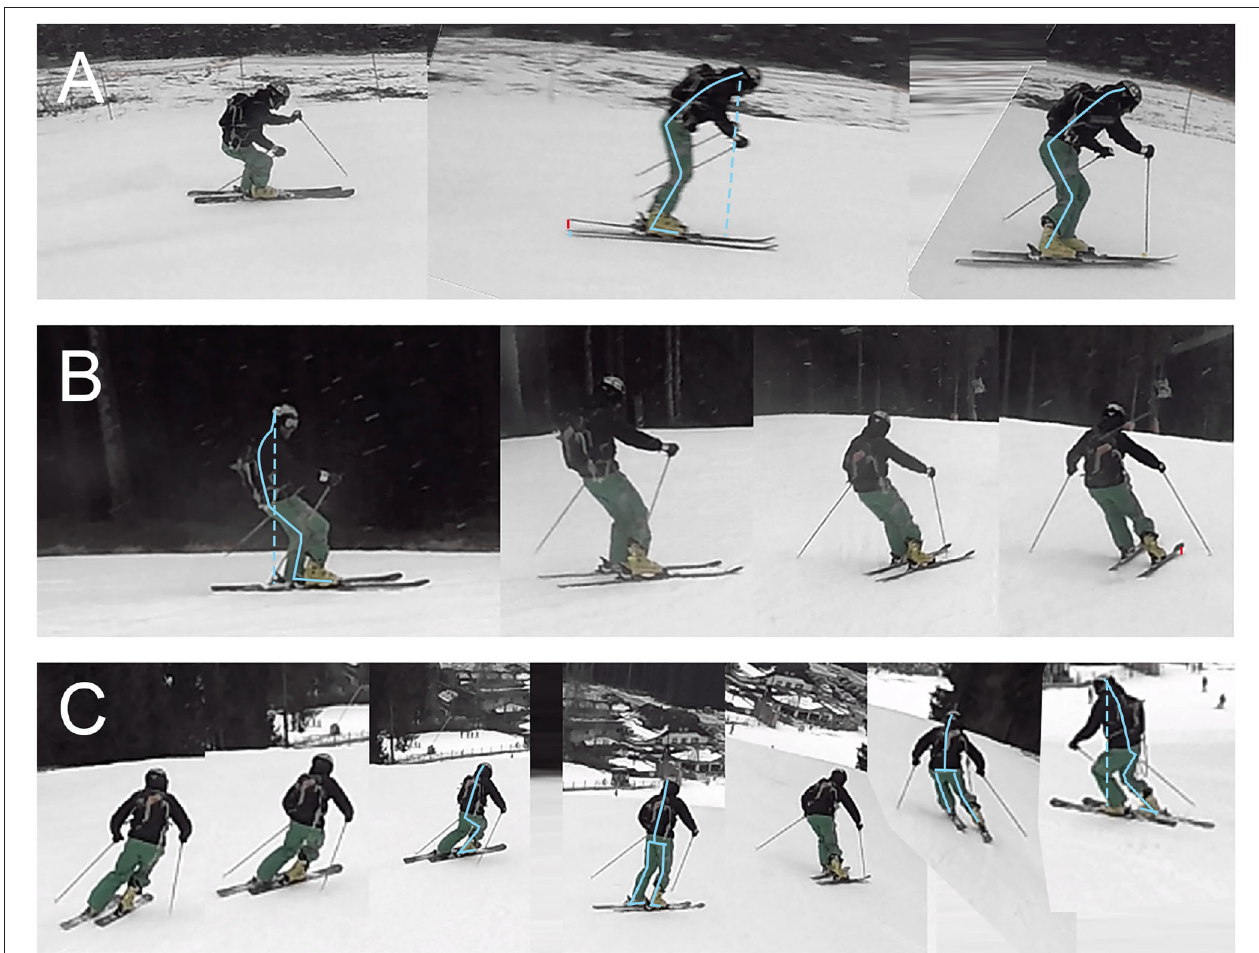
FIGURE 10 | Still frames from video footage: (A) Forward lean skiing. Strong upper body overhang with overdone steering initiation via the ski’s shovel (B) Lay-back positions with center of mass clearly behind the foot area. Upper movement necessary to initiate a turn. No distinct hip bend and no clear longitudinal foot separation (skiing direction). Nonetheless, a slight forward lean during the turn transition was necessary. (C) Balanced skiing with clear hip bend and compact body position. The body extends during the turn transition and unloading of the